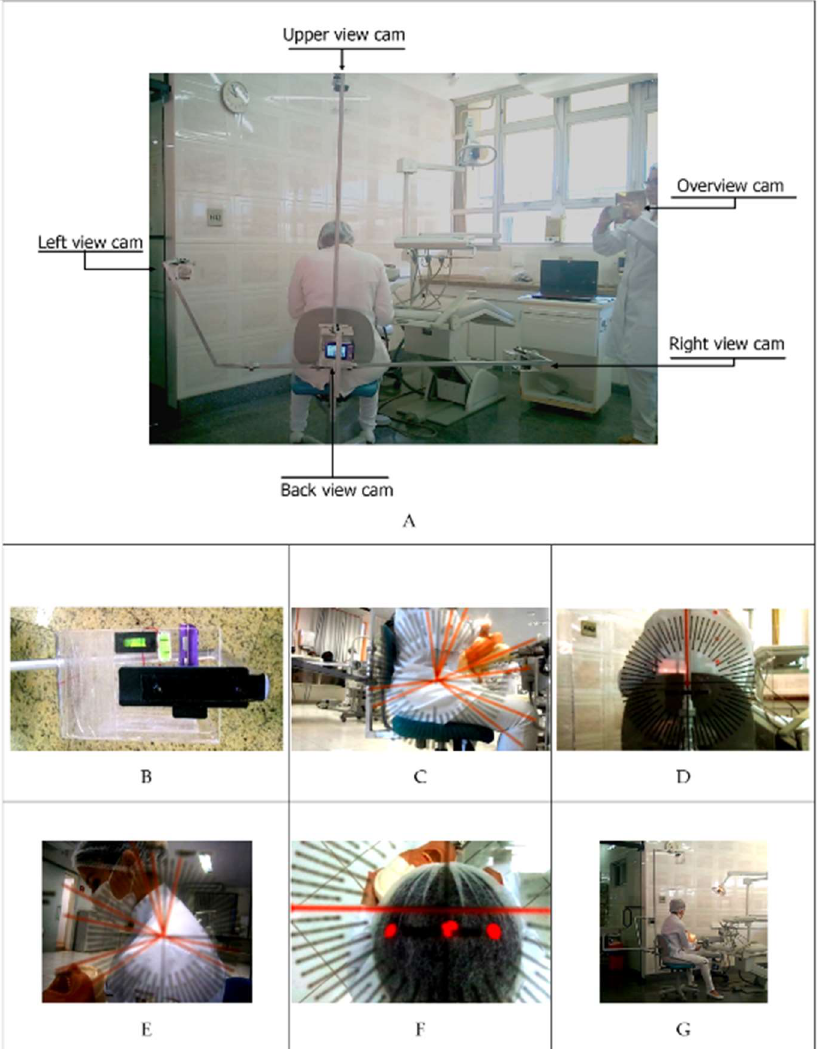
Figure 3. Device built to support cameras 1 to 4, camera 5 positioning and views obtained by each of the cameras. ( A ) Positioning of the 5 cameras; ( B ) Transparent acrylic support with the parameters and limits of angular inclinations and bubble levels to keep cameras straight; ( C ) Right view; ( D ) Back view; ( E ) Left view; ( F ) Upper view; ( G ) Overview camera. Table 1. Parameters used as limits of inclination, according to the body segment and positioning of cameras used for evaluation [4,17,29,30,32,33,36]. attributed to each of the 12 requirements